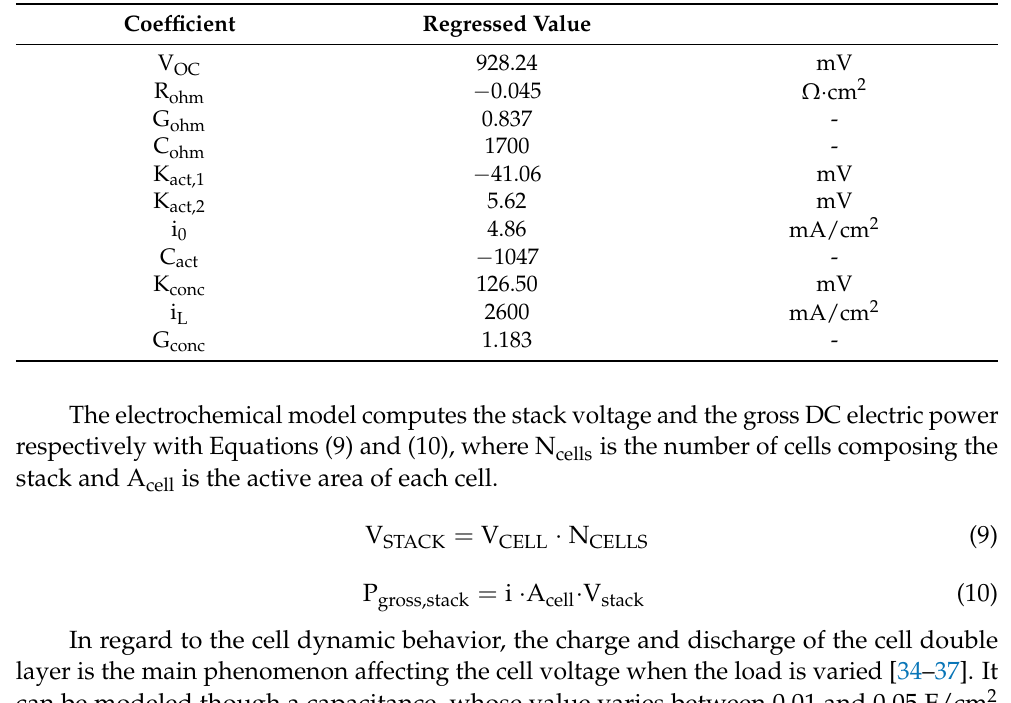
Table 1. Polarization curve coefficients regressed on experimental